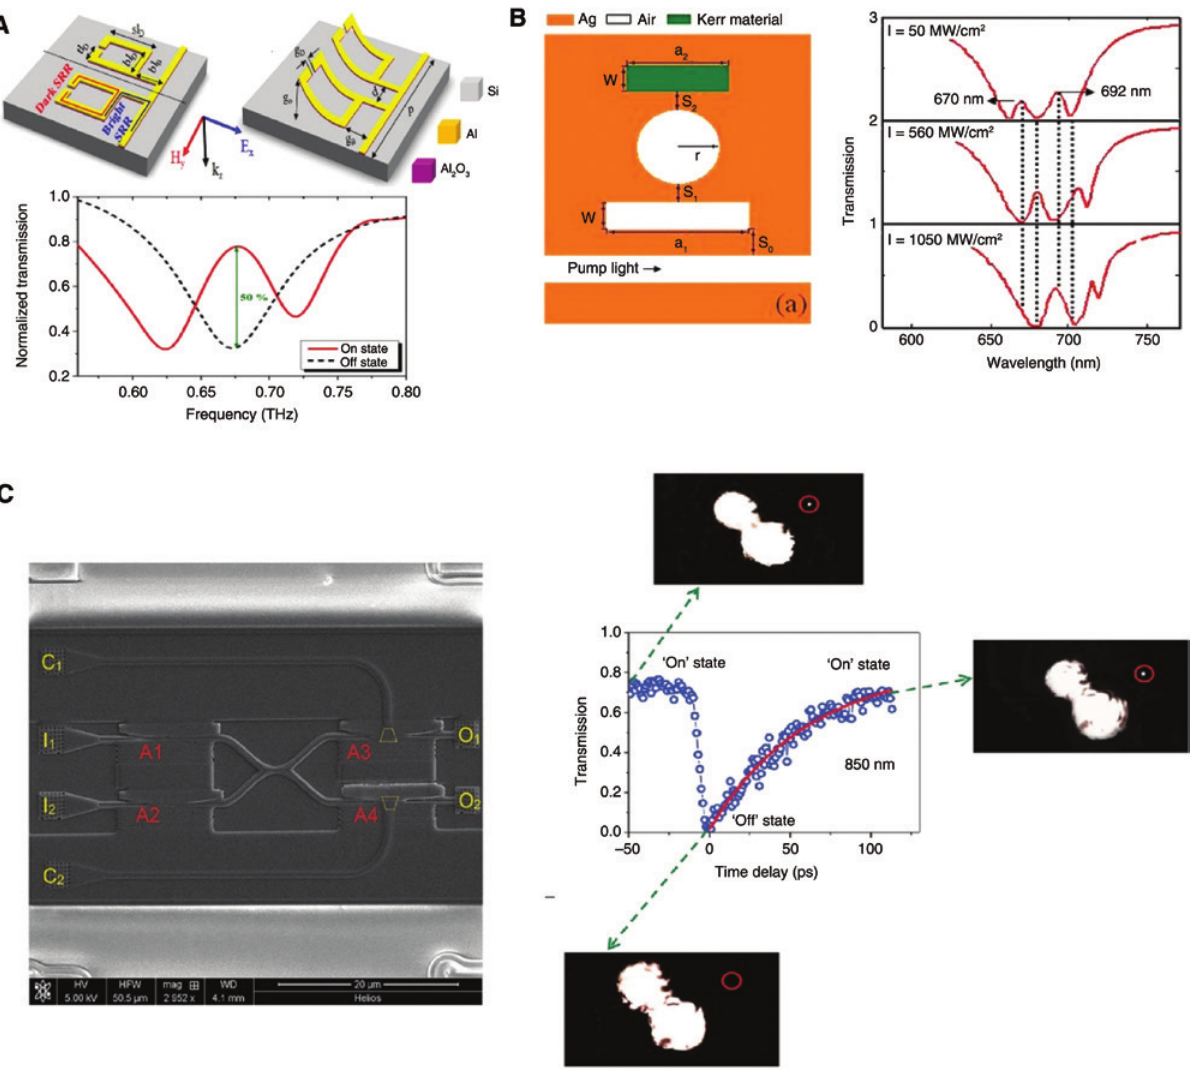
Figure 6: Device configurations of optical switching based on PIT effects. (A) MEM PIT optical switching based on two coupled ring resonators. The transition of the ON/OFF state can be realized through the physical deformation of the nanocavities [144]. (B) All-optical switching containing Kerr nonlinear nanocavities. The Ag-BaO material is filled